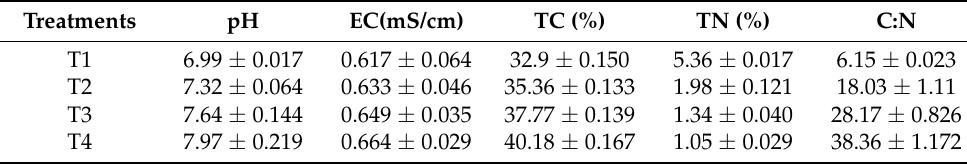
Table 2. Selected chemical properties of the treatments on the initial day (day 0).